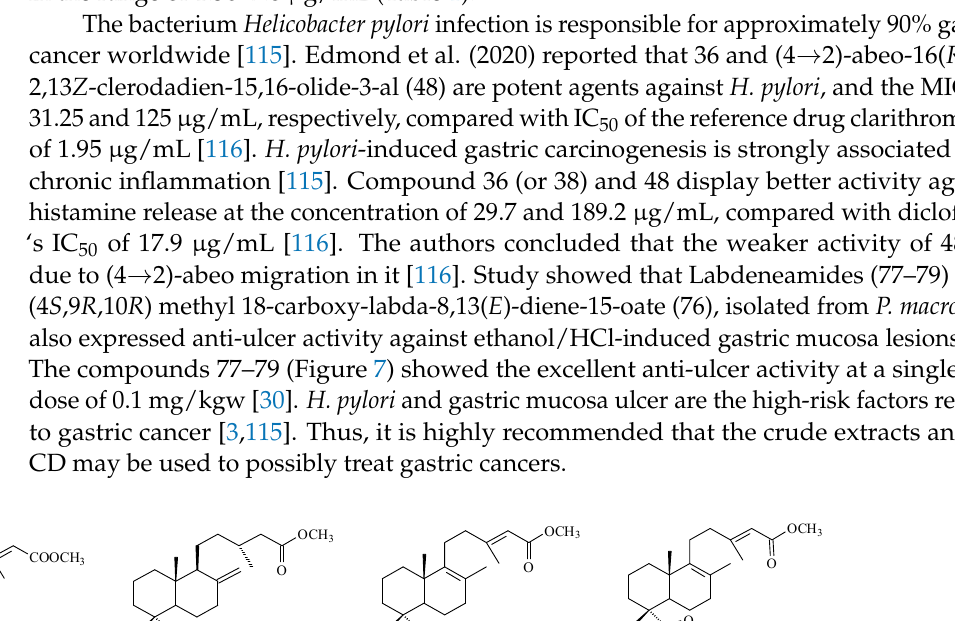
Figure 6. The phytochemical compounds isolated from species of Polyalthia have anti-bacterial (2, 10, 13–15, 22, 23, 36–38,